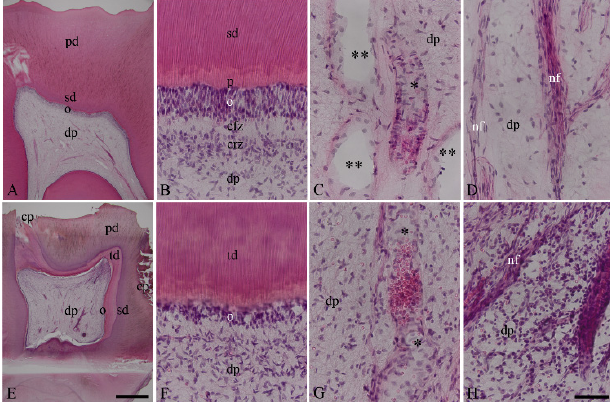
Figure 1. Histopathological characterization of healthy and inflamed human dentin–pulp complex by H&E staining. The cell layers of the healthy dentin–pulp complex are recognizable in a structural order that is characteristic of the histology of the healthy dentin–pulp complex ( A , B ). The healthy dentin–pulp complex is recognizable with primary dentin (pd), secondary dentin (sd), predentin (p), the odontoblast layer (o), cell-free zone (cfz), cell-rich zone (crz), and numerous pulp cells ( A , B ). The healthy odontoblast layer is visible without degeneration and inflammatory signs ( B ). The venous (two asterisks) and arterial (asterisk) blood vessels and nerve fibers (nf) are seen to not have inflammatory signs ( C , D ). The cell layers of the chronically inflamed dentin–pulp complex do not have a structural order ( E ). The chronically inflamed dentin–pulp complex is associated with deep dentin carious lesions in occlusal and in approximal areas (cp). In addition to areas of primary dentin (pd) and secondary dentin (sd), areas of tertiary dentin (td) are found beneath the caries lesions. Several inflammatory cells are found in the dental pulp ( E ). In the odontoblast layer (o), degeneration vacuoles are observed ( F ). In the chronically inflamed dental pulp, dilated blood vessels and nerve fiber are associated with numerous inflammatory cells ( G , H ). Scale bar: ( A , E ) = 1 mm; ( B – D , F – H ) = 50 µ